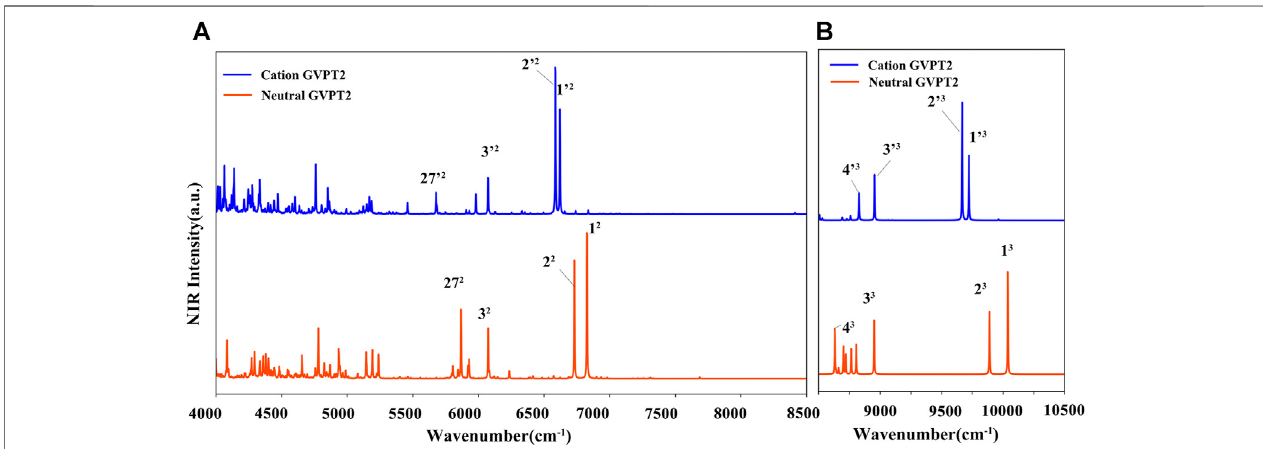
FIGURE 9| (A) (B) NIR spectra simulated at GVPT2//B2PLYP//B3LYP/AVTZ level.Spectra were broadened by Lorentzian functions with HWHM of1 cm − 1 . Most intense bands are assigned as m n where n -number of quanta and m is the normal mode.